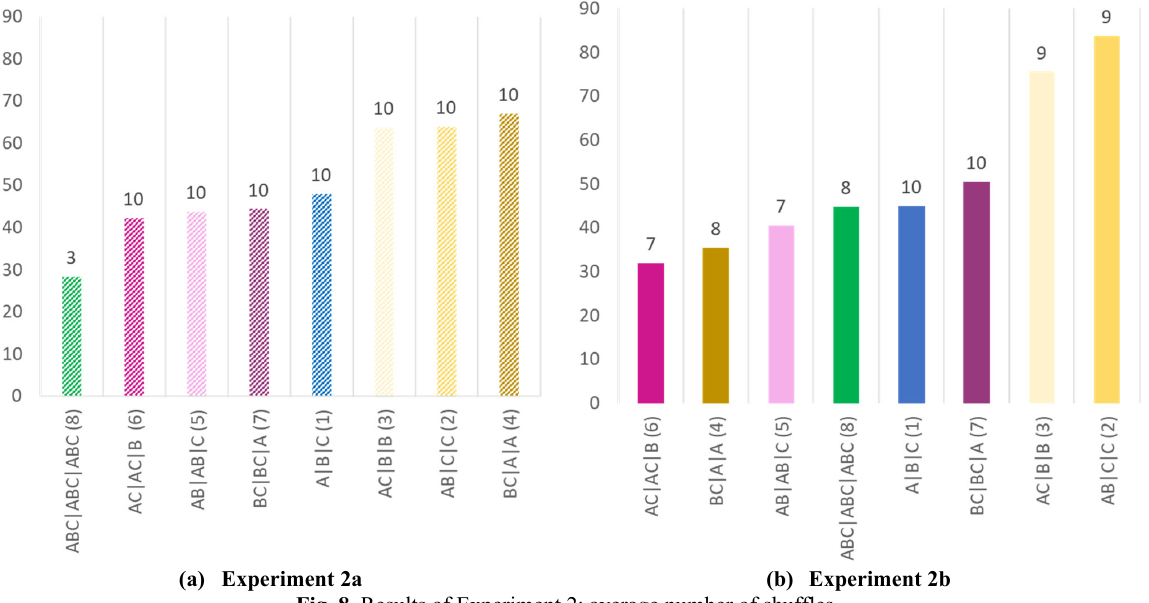
Fig. 8. Results of Experiment 2: average number of shuffles Results of Experiment 2: average computational times (sec.) Distribution